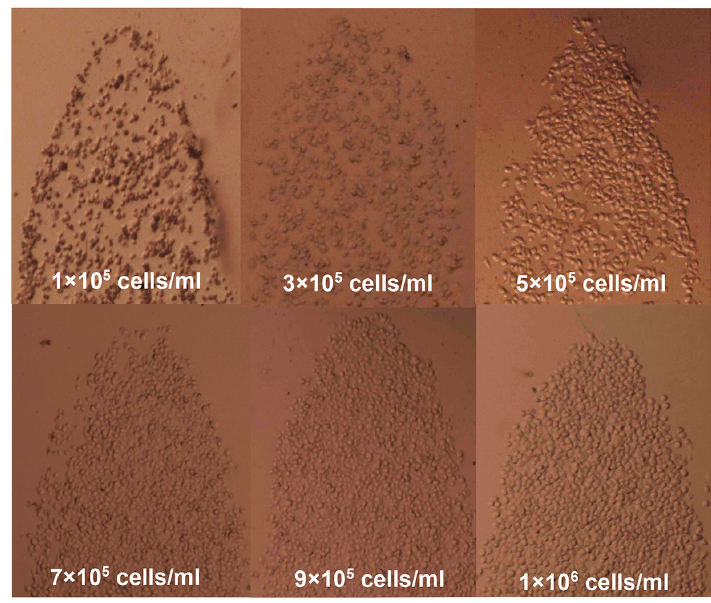
Figure 12. Partial views of the primary lens made up of different Hela cell densities including 1 × 10 5 cells/mL, 3 × 10 5 cells/mL, 5 × 10 5 cells/mL, 7 × 10 5 cells/mL, 9 × 10 5 cells/mL, and 1.0 × 10 6 cells/mL.